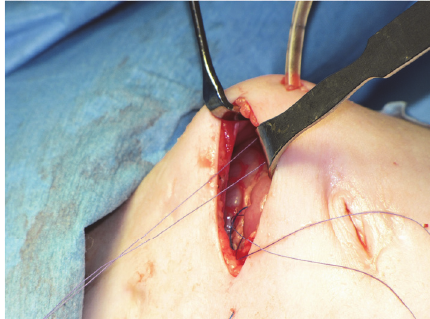
Figure 8: Weight development in patient 1 suffering from Wilkie syndrome